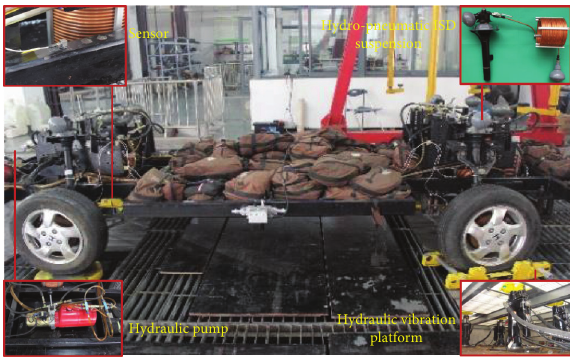
Figure 9: Vehicle test system for hydro-pneumatic suspensions. Table 7: Test